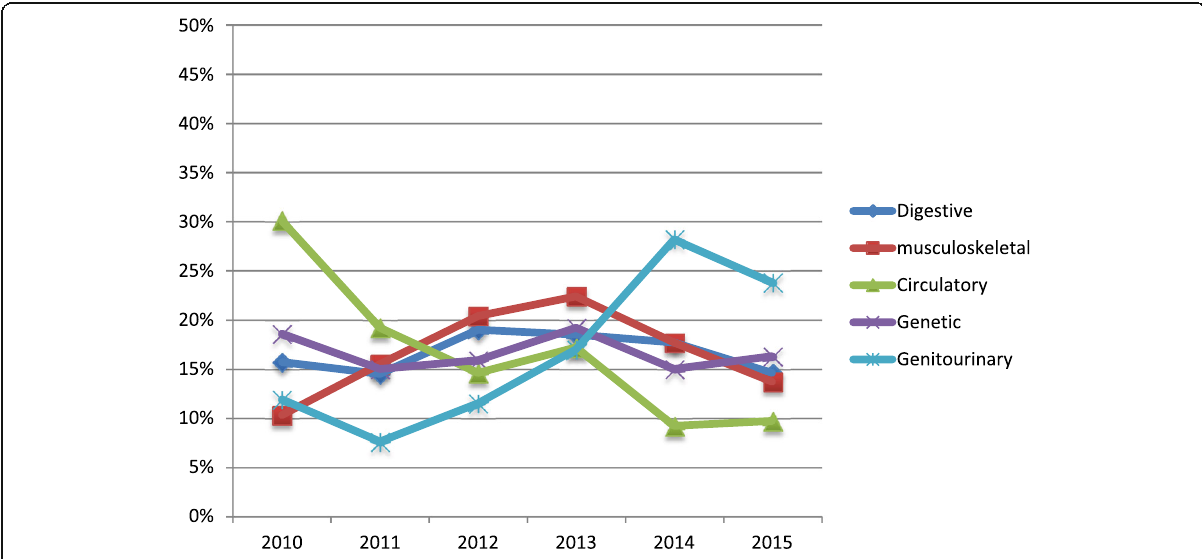
Fig. 1 Pattern of the most common CAs in the Pediatric University Hospital, Alexandria, Egypt, 2010 –